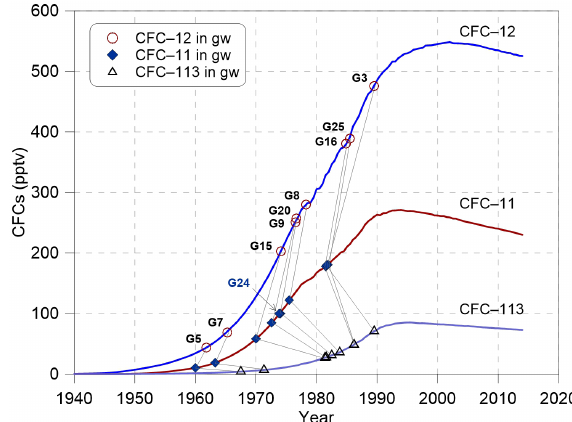
Figure 3. Concentrations of CFC-11, CFC-12 and CFC-113 (pptv) in the groundwater of this study area sampled in 2015 compared with the time series trend of Northern Hemisphere atmospheric mixing ratio at a recharge temperature of 10 ◦ C. Data are available at https://water.usgs.gov/lab/software/air_curve/index.html (last ac- cess: 27 October